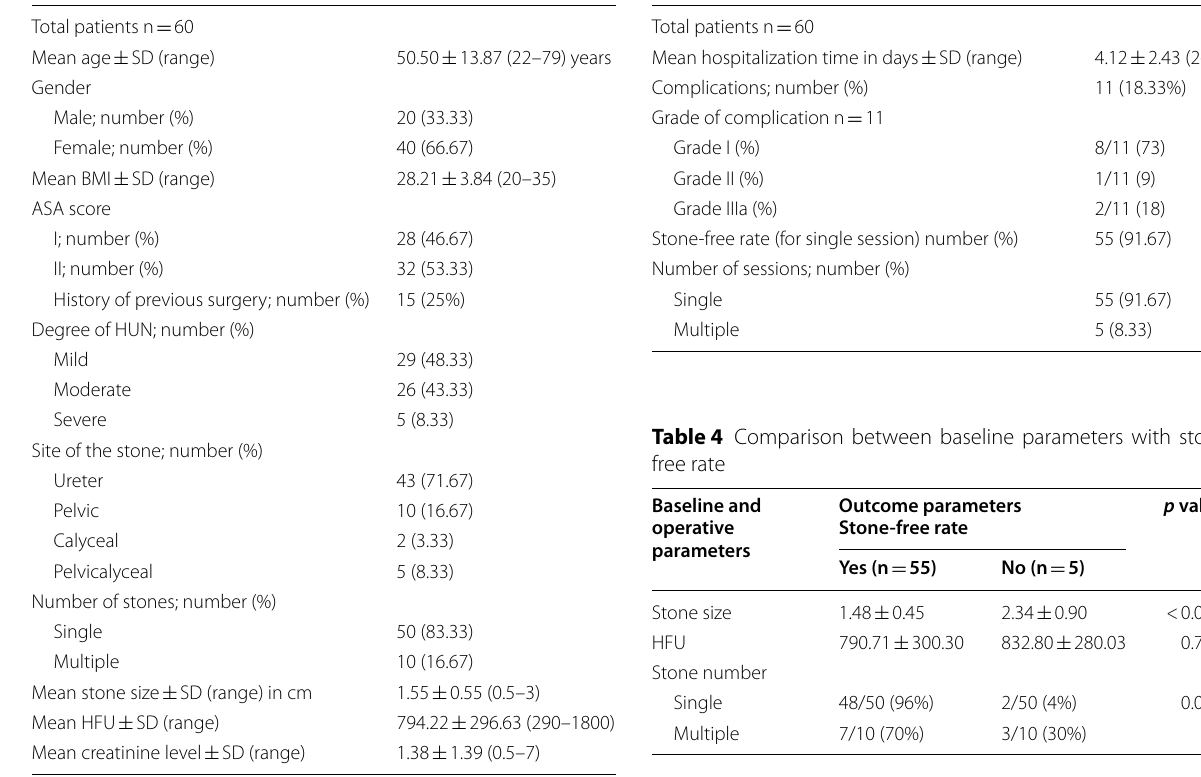
Table 3 Postoperative data